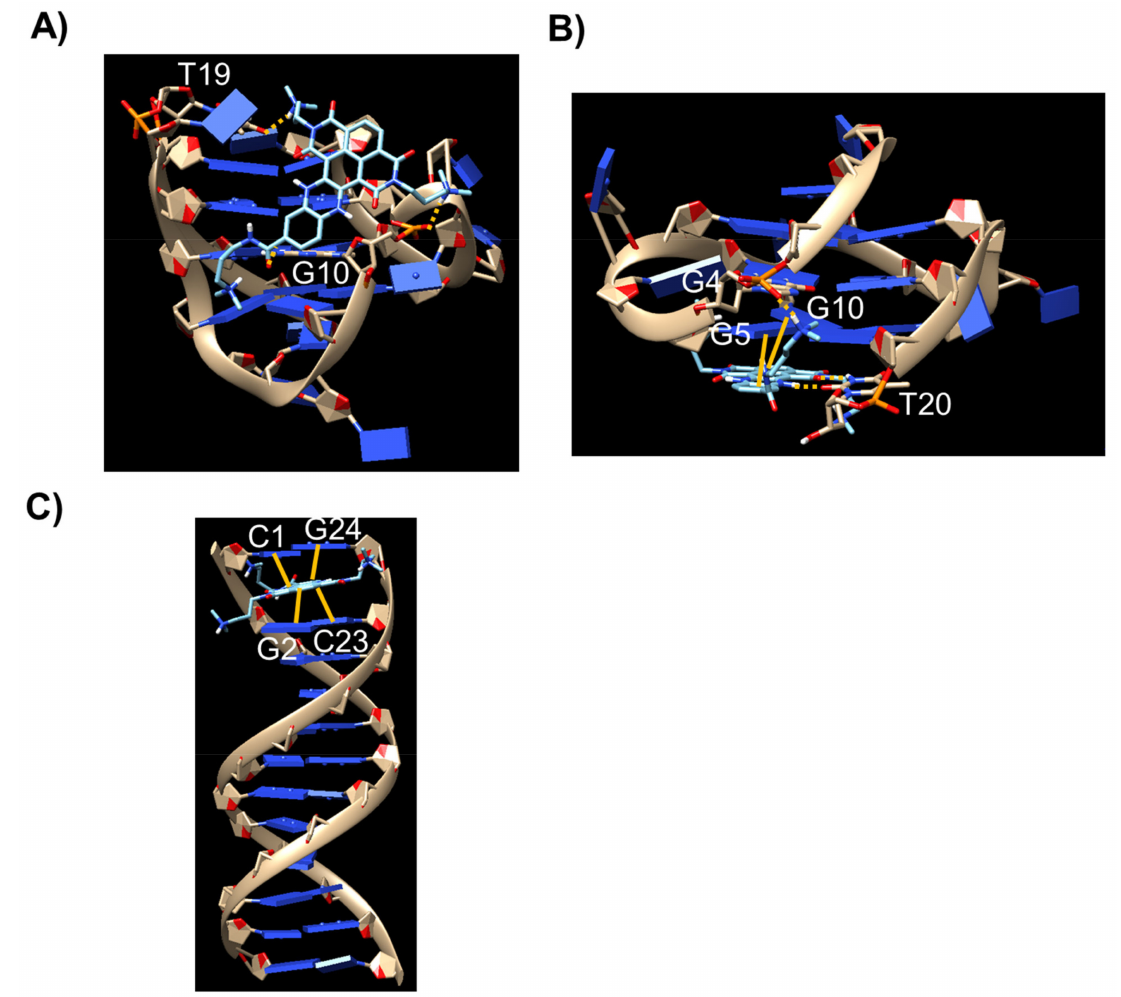
Figure 8. Binding mode of c ex -NDI when docked into ( A ) m-tel24 G-quadruplex, ( B ) M2 G-quadruplex and ( C ) ds12 duplex. c ex -NDI is represented as cyan sticks. Hydrogen bonds and electrostatic interactions are shown as yellow dashed lines while stacking interactions are shown as yellow bold lines. DNA residues involved in the interactions are indicated in each